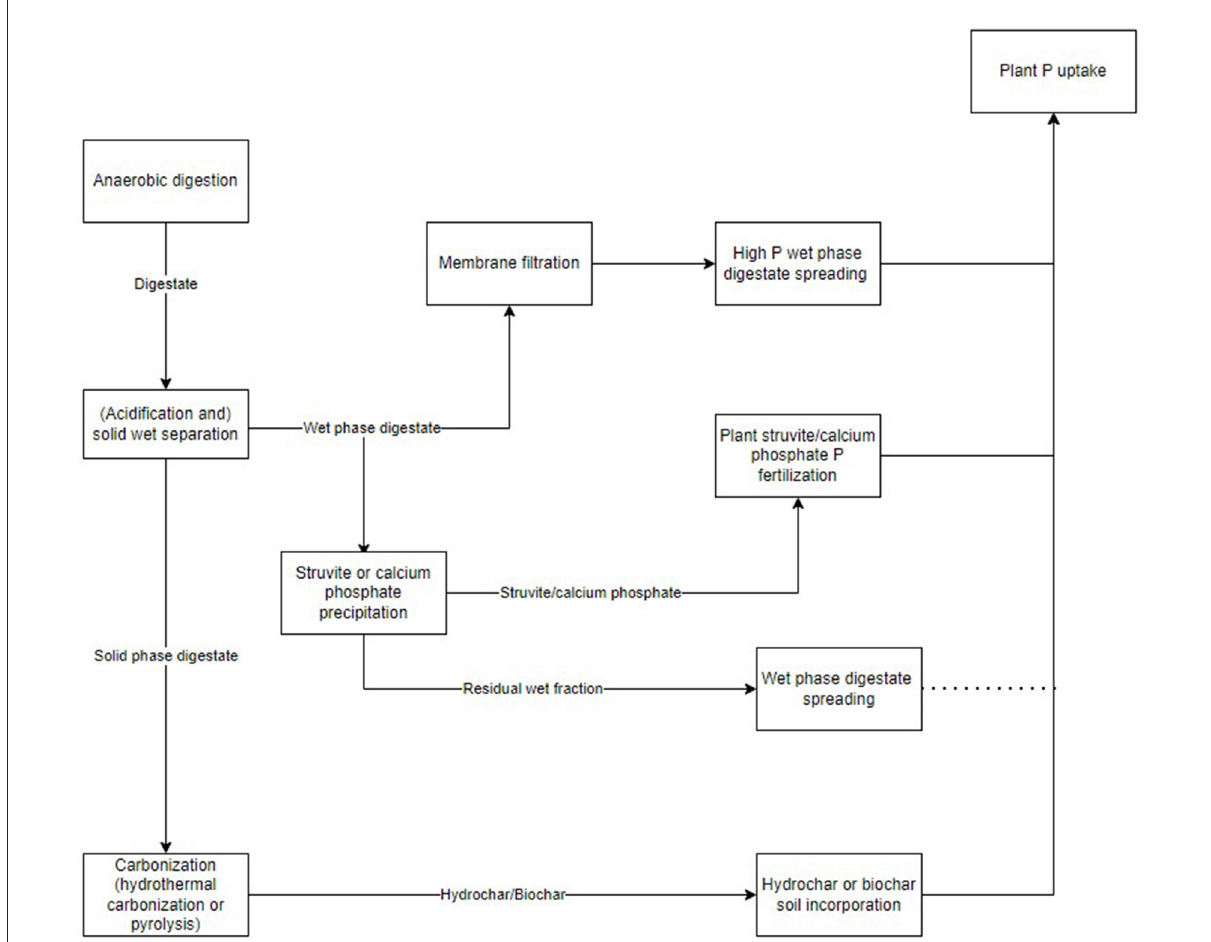
FIGURE1 Digestate processing and agronomic use alternatives included in this